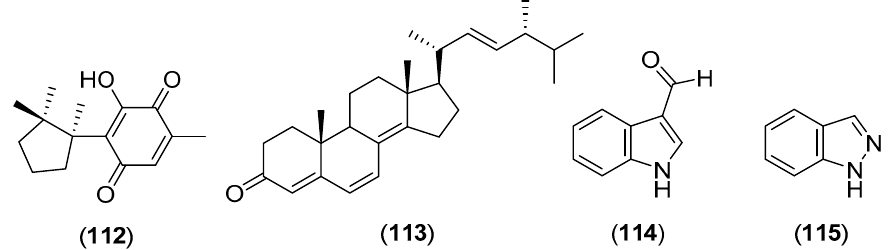
Figure 20. Chemical structures of selected compounds isolated from Volvariella bombycina.